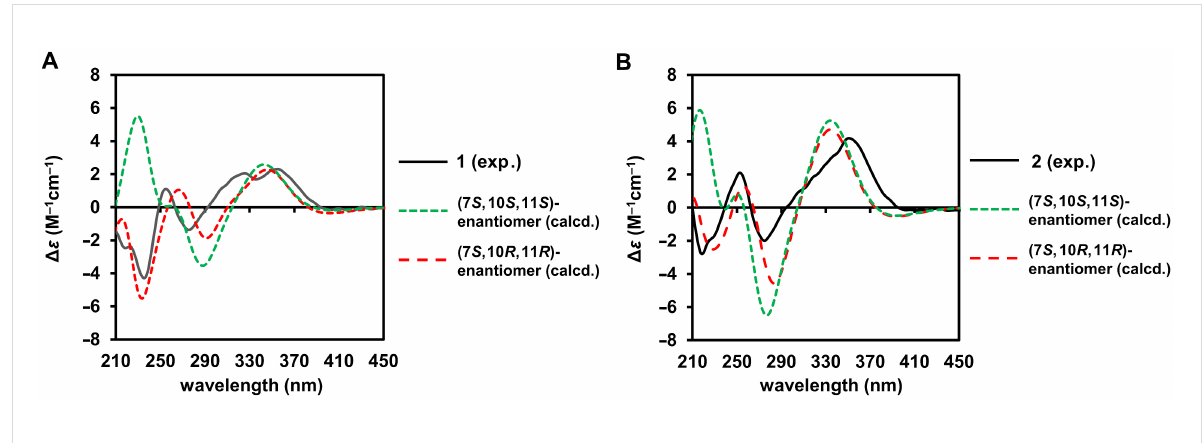
Figure 4: Comparison of the experimental ECD spectra (black solid line) of 1 (A) and 2 (B) with the Boltzmann-weighted spectra computed for the (7 S ,10 S ,11 S )- and (7 S ,10 R ,11 R )-stereoisomers (green and red dashed lines, respectively) of the simplified models.